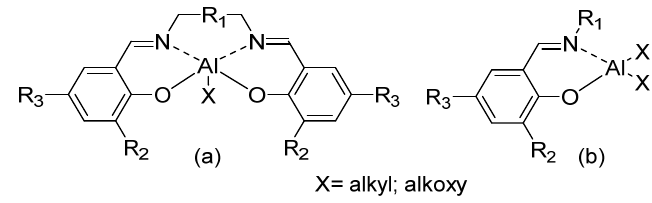
Figure 1. SALEN-Al ( a ) vs. “half-SALEN” salicylaldiminato-Al ( b ) complexes.